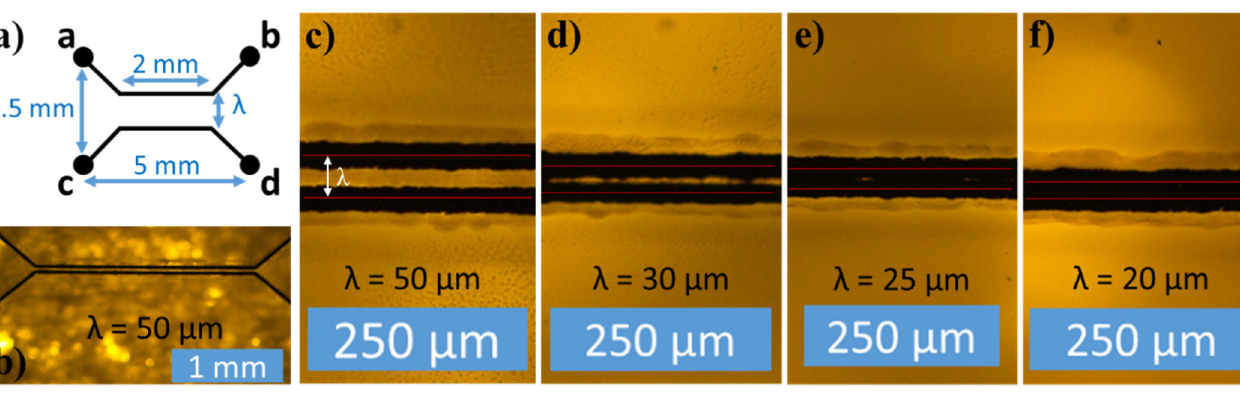
Figure 13. ( a ) Schematic of test structure, ( b ) image of test structure , ( c ) lines insulated, ( d ) lines still insulated, ( e ) insulation of lines starts to break down, ( f ) insulation of lines completely broken down. The red lines indicate the center of the beam trace with λ being the pitch between the two trace centers. All lines were written at 80 mW and 0.1 mm/s scan speed.